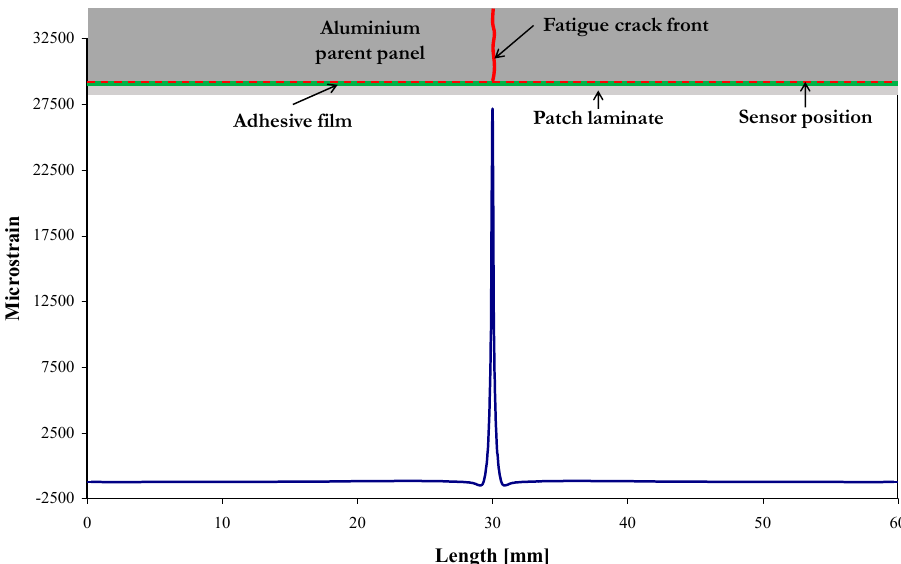
Figure 13. Predicted strain profile along the position of the 60 mm sensor in the damaged model (12.5 mm crack) when loaded at 6 kN.